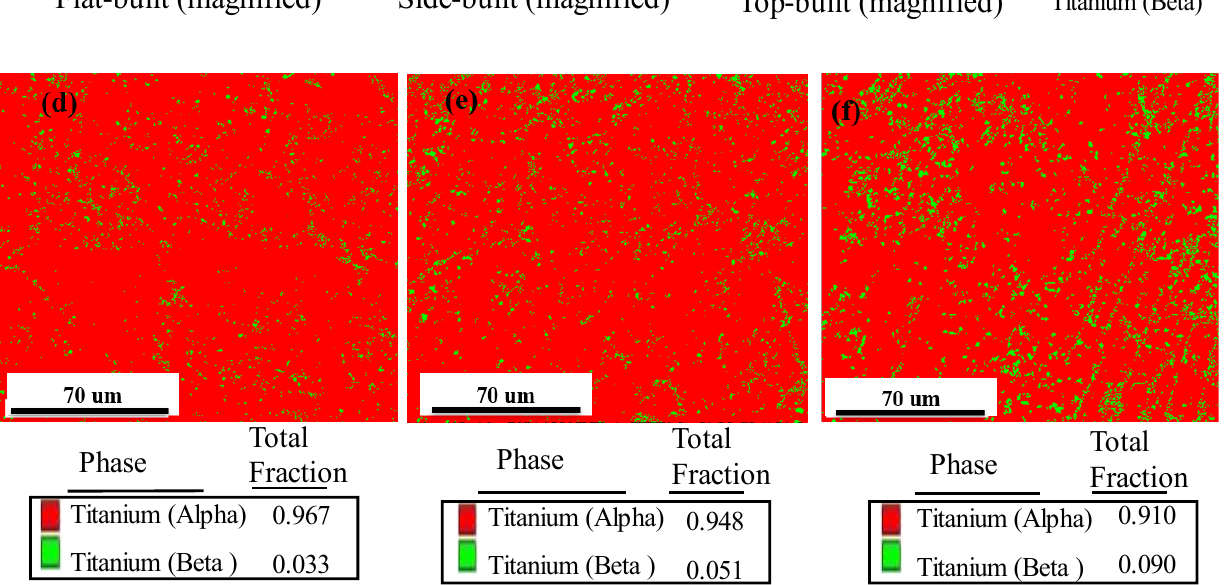
Figure 8. Various EBSD maps of the three Ti6Al4V samples. The top three inverse pole figure (IPF) maps show different preferred grain orientations on the three samples. IPF maps at higher magnification display ( a ) elongated grain boundary, ( b ) alpha colonies, ( c ) alpha basketweave platelets, while phase maps ( d – f ) show prior beta phases in between the alpha grain boundaries of flat-built, side-built, and top-built samples, respectively.